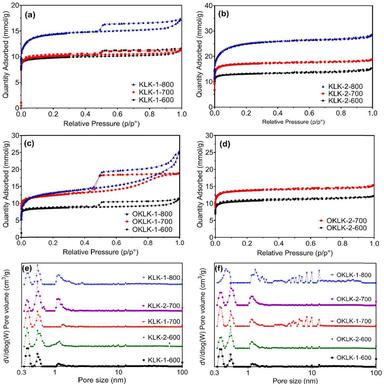
N2 adsorption isotherms obtained at − 196 ℃ for KLK carbons (a) (b) and OKLK carbons (c) (d); NLDFT pore size distributions for KLK carbons (e) and OKLK carbons (f).